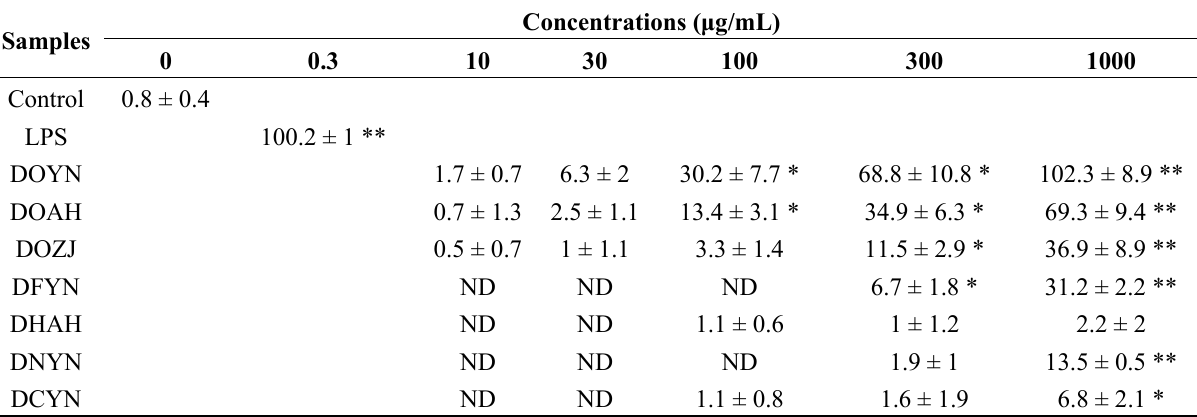
Table 2. Effects of crude polysaccharides from Dendrobium on NO release from RAW 264.7